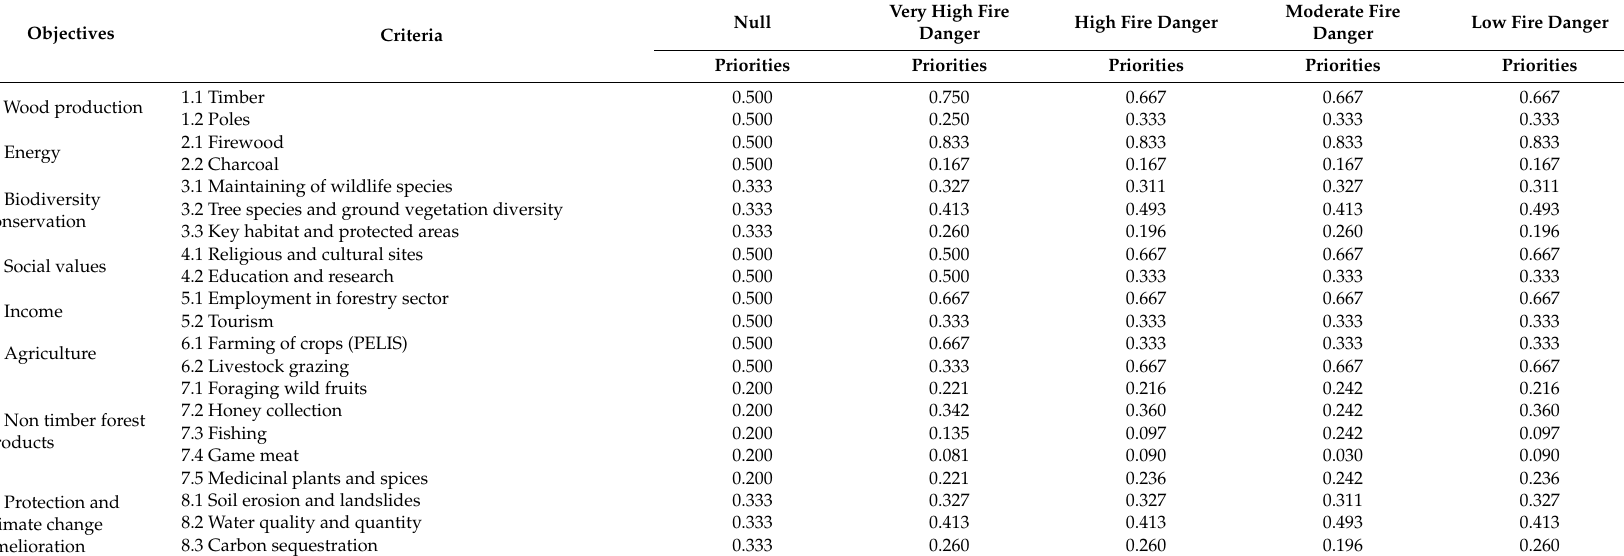
Table A3. Priorities of the criteria in the seven forest stations according to the four fire danger categories after pairwise comparison (PWC) by